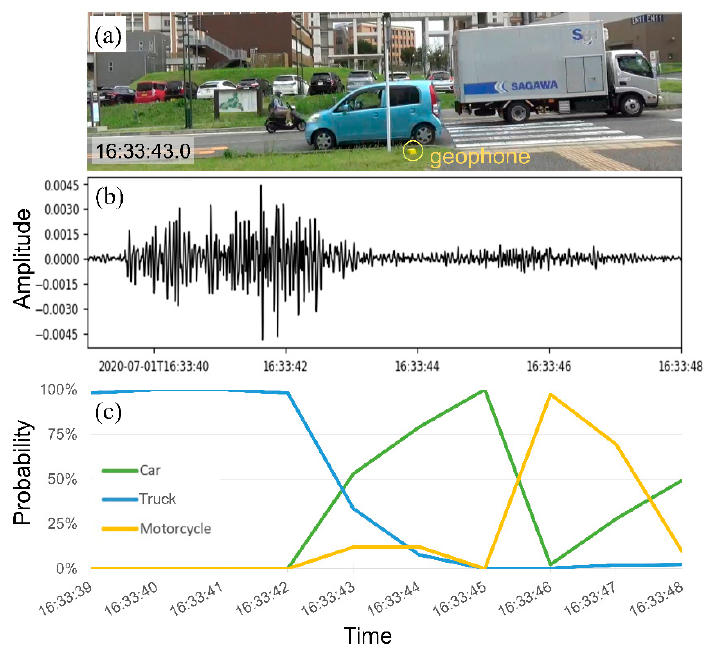
Figure 9. ( a ) A video frame documenting several vehicles passing the receiver at time 16:33:43. ( b ) The seismic noise generated a 10 s window. ( c ) Vehicle type probabilities estimated by CNN at intervals of 1 s during the window in ( b ) contain 10 interpretation points with 80% overlapping.